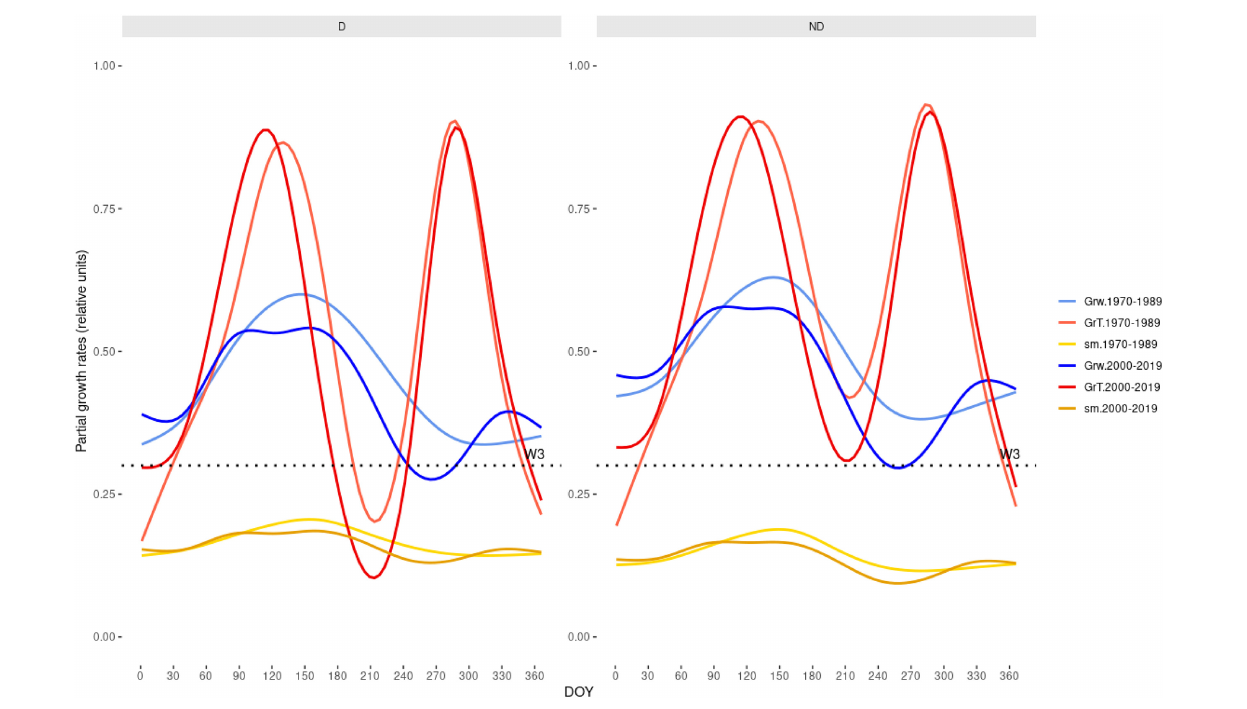
FIGURE 6 | Tree growth is becoming more limited by warmer and drier climate conditions according to the Vaganov-Shashkin (VS) model simulations. The plot shows the partial Grs driven by soil moiture (GrW) or temperture (GrT) limitations of growth, and depending on soil moisture (sm) during the year ( X -axis shows DOY). We compared wet-cool (1970–1989, mean annual water balance –673 mm) and dry-warm (2000–2019, mean annual water balance –873 mm) periods in the case of the trees from the Miedes site. The W3 is the soil moisture threshold needed for growth (refer Supplementary Table 1